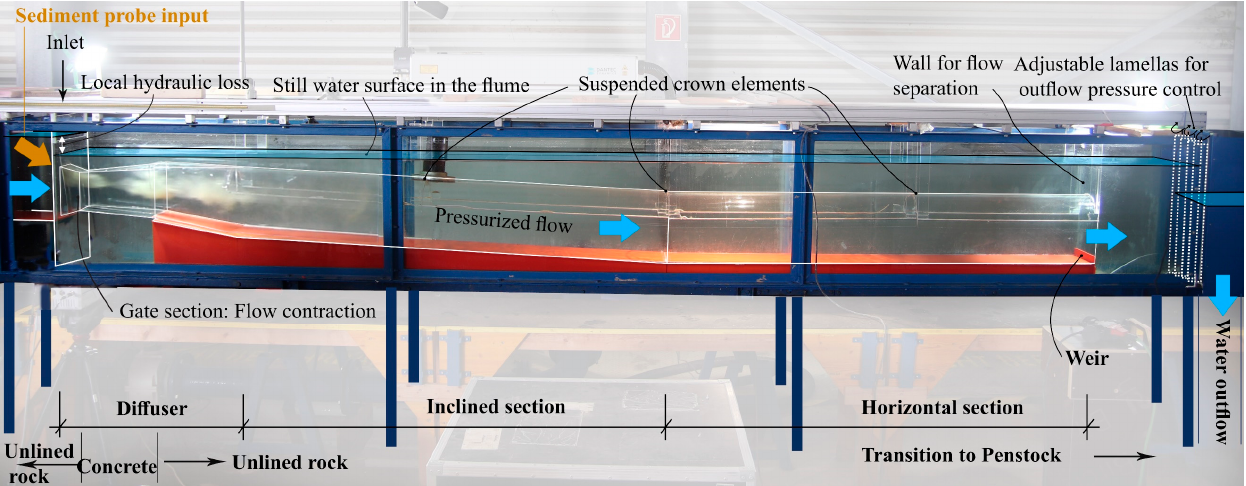
Figure 4. The physical scale model test with 1:36.67 geometrical scale, 1:1 velocity, and sediment scaling in the 30 cm wide flume of the hydraulic laboratory.